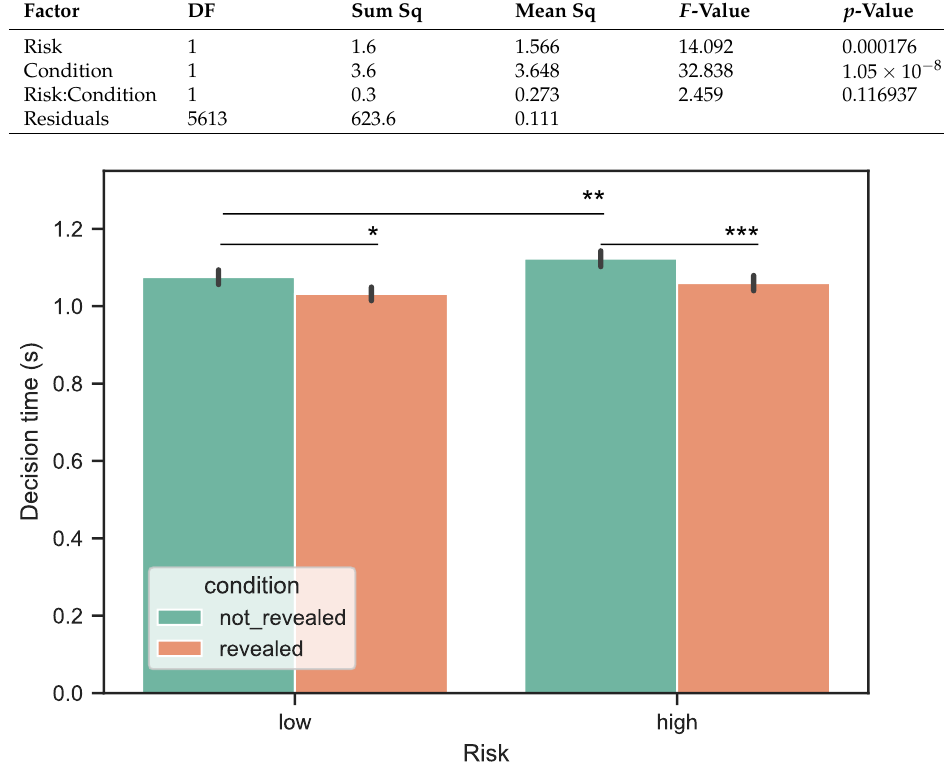
Figure 6. The duration of the decision-making phase where the participants had to choose either to check the model’s prediction or delegate the decision to the AI. The error bars indicate confidence intervals of 95% computed using bootstrapping. The individual data are not shown to not overload the figure. The indicators of significant differences obtained from the ANOVA analysis are *: p < 0.05, **: p < 0.005, and ***: p < 0.001. Not significant differences are not